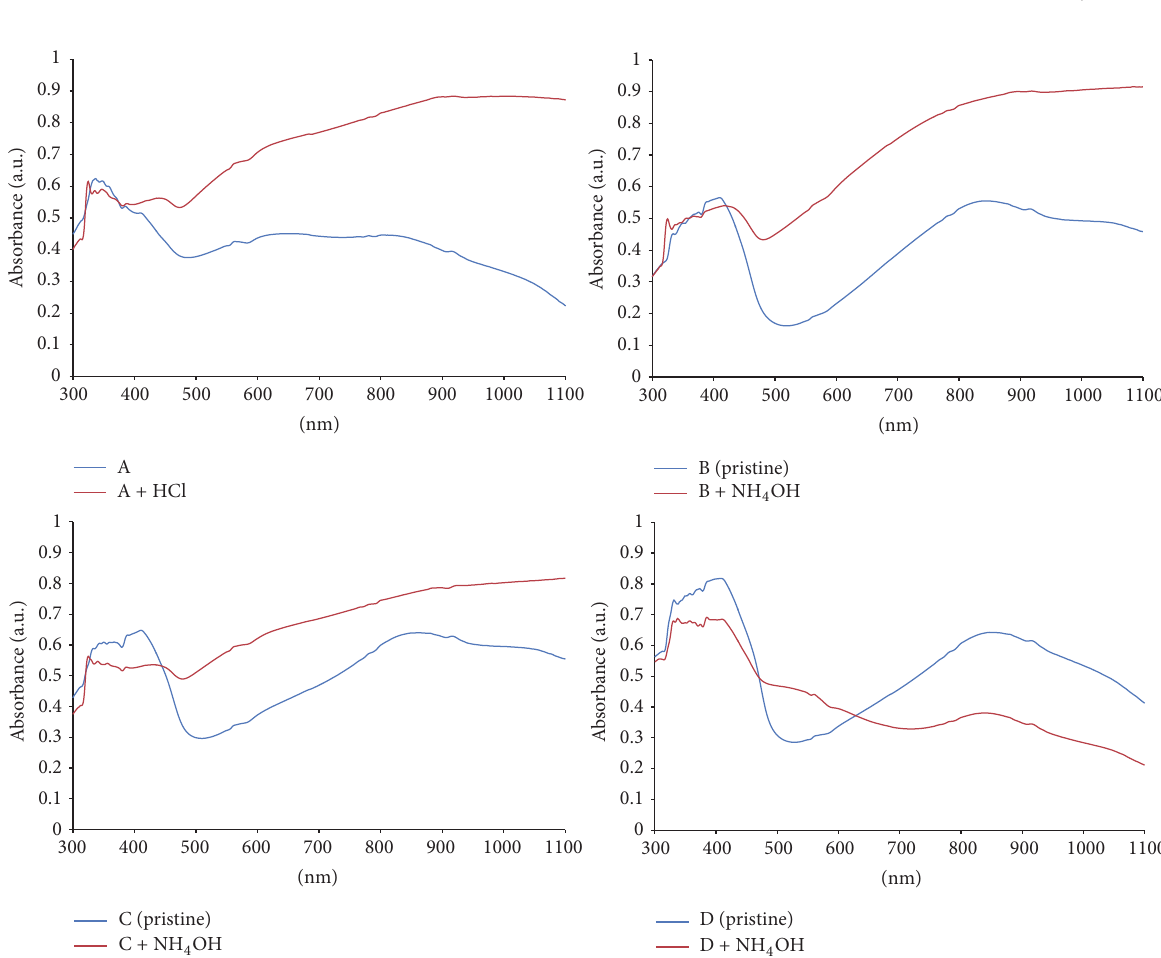
Figure 9: Vis-NIR spectra of the membranes before the impact of the analyzed factor (blue) and after treatment with 0.0001 M (0.1ppm) solution of the test agent